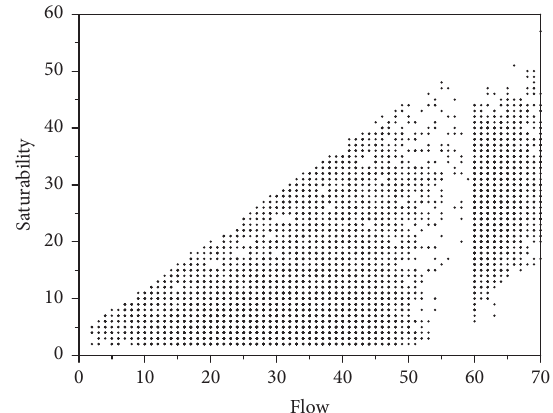
Figure 10: Scatter diagram of the relationship between clustering data flow and saturation.